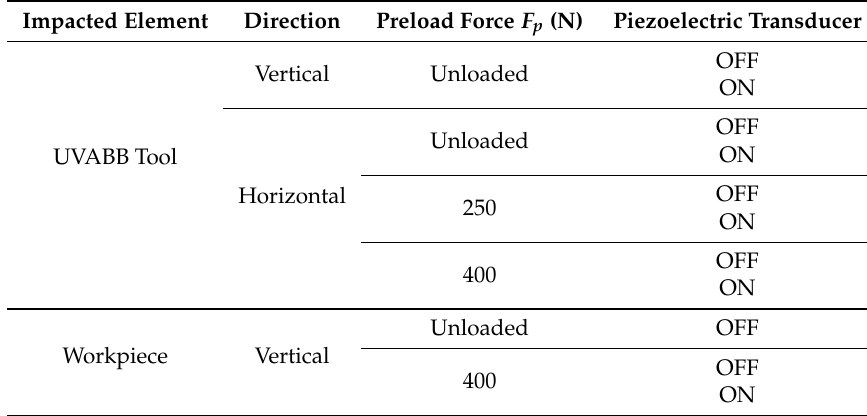
Figure 4. Schemes showing all types of performed impacts. ( A ) Vertically on the tool; ( B ) Horizontally on the tool; ( C ) Vertically on the workpiece attached to the dynamometric table. Table 3. Conditions under which all impact tests were